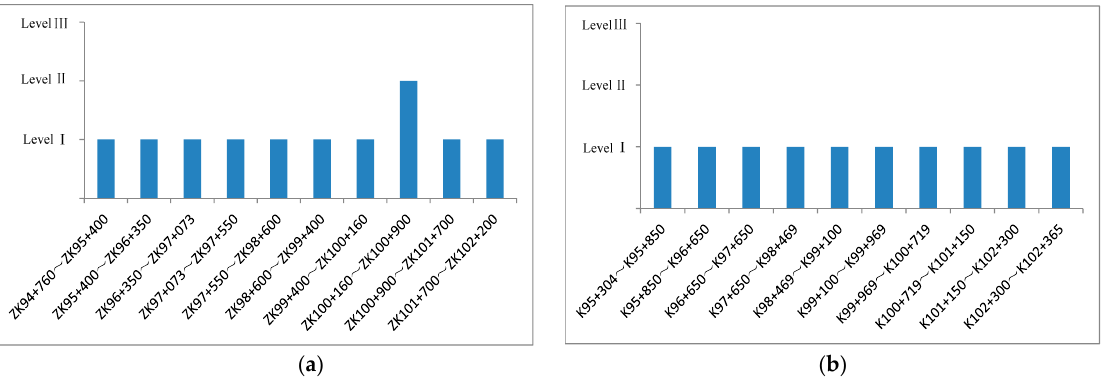
Figure 11. Structural safety status of Cang Ling Tunnel at present. ( a ) Left line; ( b ) Right line.